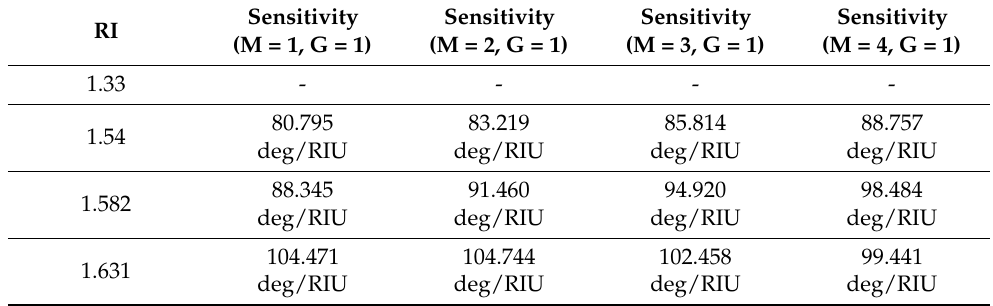
Figure 6. Plot showing sensitivity as a function of RI of sensing layer by varying ( A ) MXene layers with a monolayer of MoS 2 , ( B ) MoS 2 layers with a monolayer of MXene.